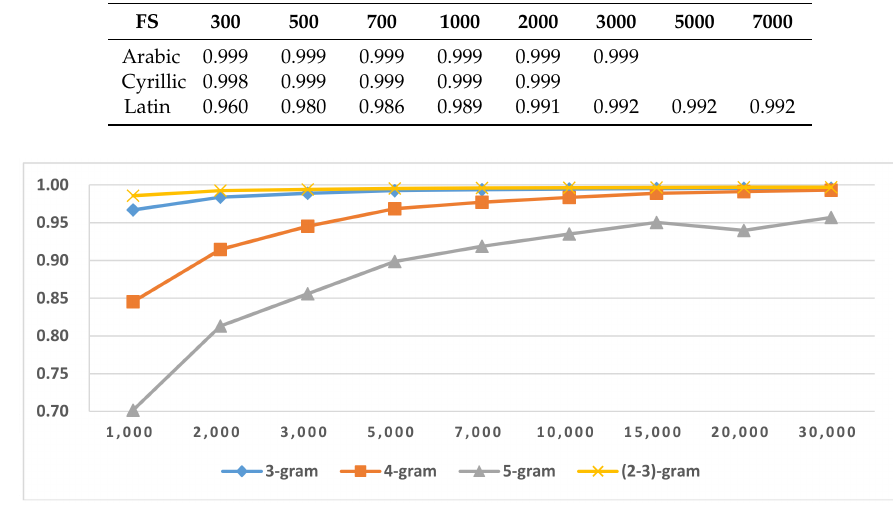
Figure 15. LGI in Latin script languages.